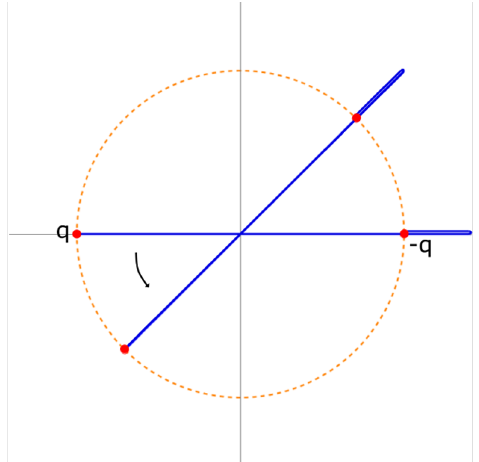
Figure 3 . The rotating solution of a neutral string with endpoint charges in a magnetic field. The charges rotate around the central point between them. The magnetic field is in the z direction, coming out of the plane, and the rotation is